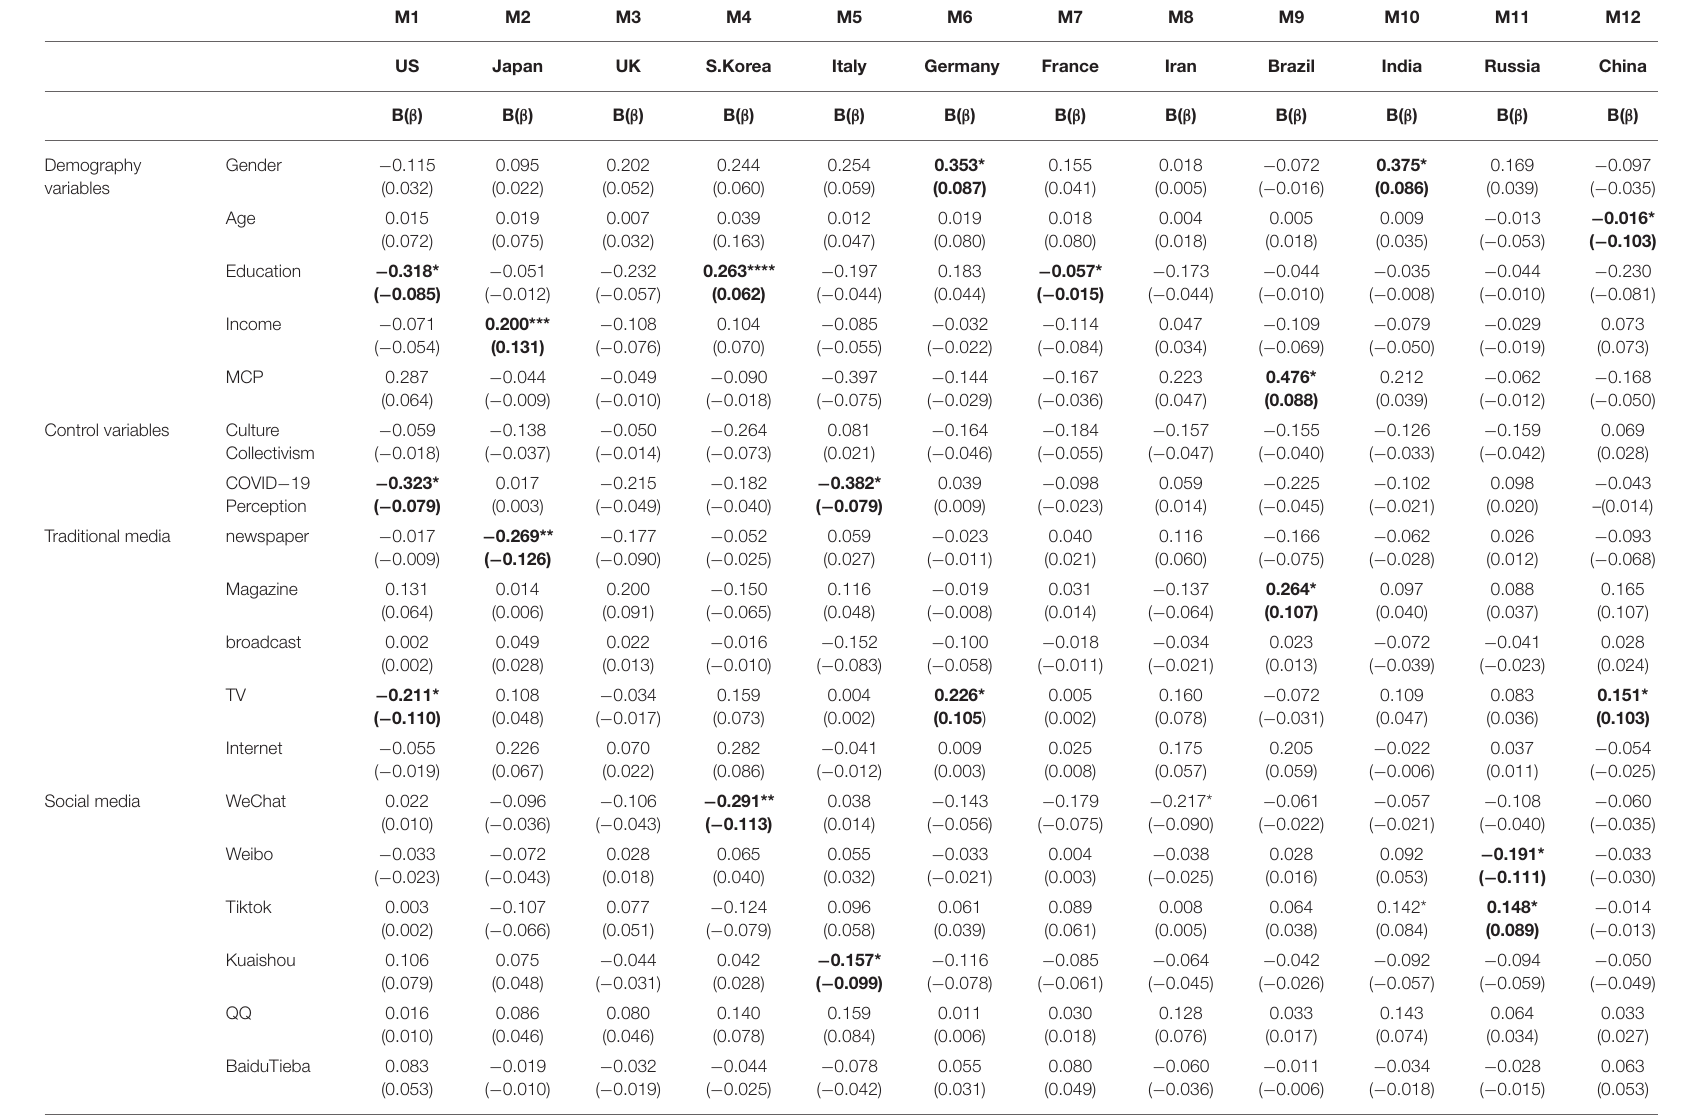
TABLE 3 | Regression analysis for evaluation of controlling-pandemic of the Chinese public in different